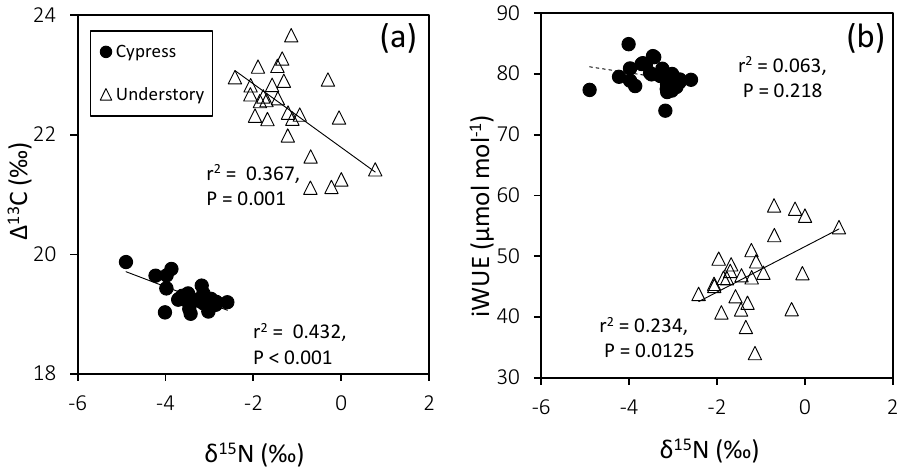
Figure 5. Relationships between leaf δ 15 N and Δ 13 C ( a ) and between leaf δ 15 N and iWUE ( b ) of hinoki cypress and understory vegetation.